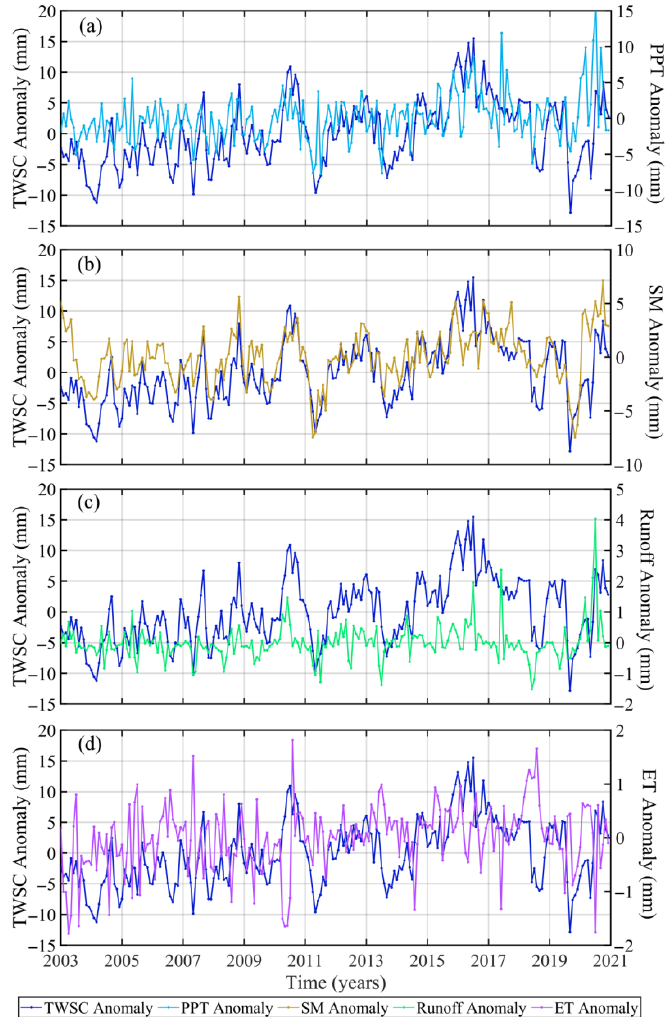
Figure 8. The time series of TWSC and four hydrometeorological factor anomaly (( a ), PPT; ( b ), SM; ( c ), runoff; ( d ), ET) during 2003~2020 in the MLY.